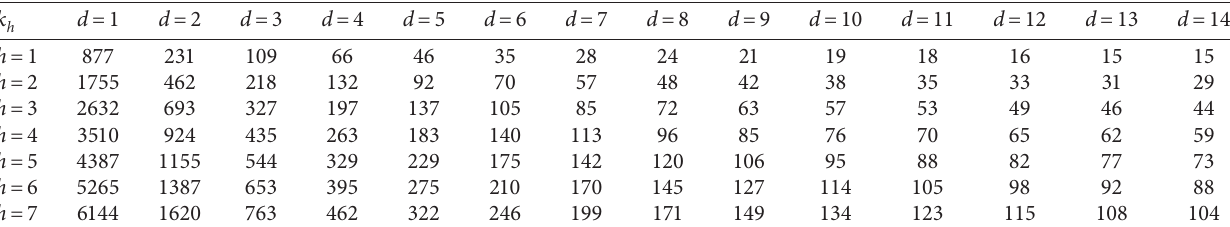
Table 2: The stiffness of foundation spring calculated by equation